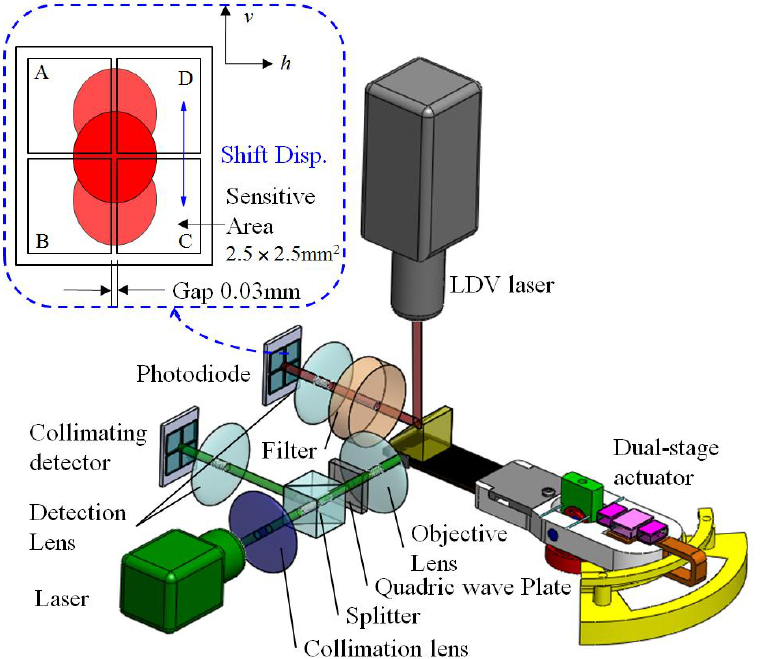
Figure 19. Geometrical model to detect the optical angle: optical layout for the differential detection method and focal spot shifts along the photodiode ( v